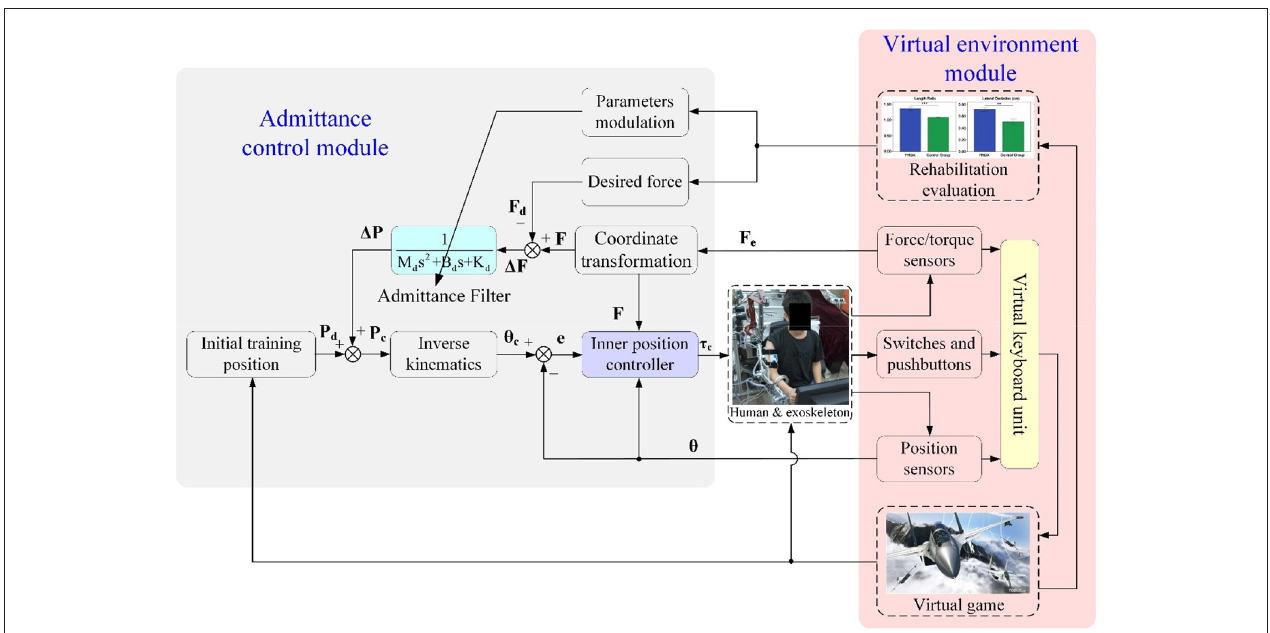
FIGURE 4 | Overall block diagram of the proposed admittance-based patient-active control